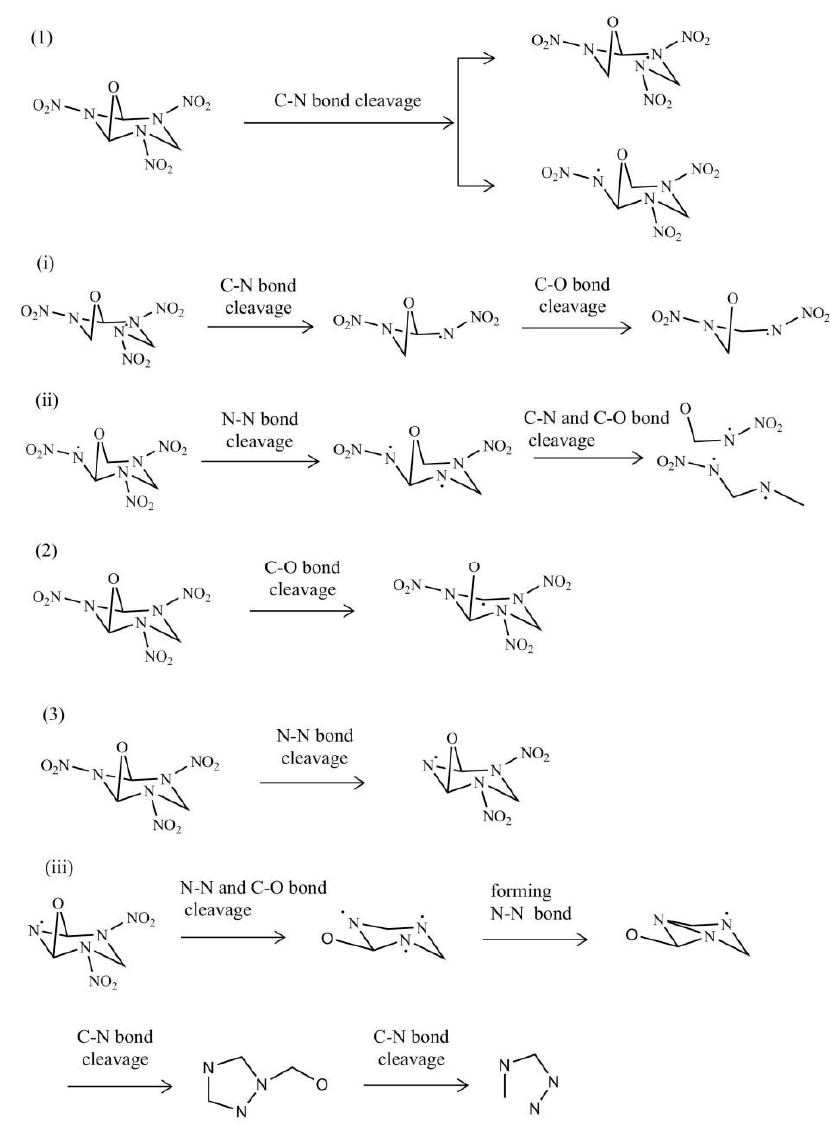
Figure 8. Subsequent decomposition process of the R3